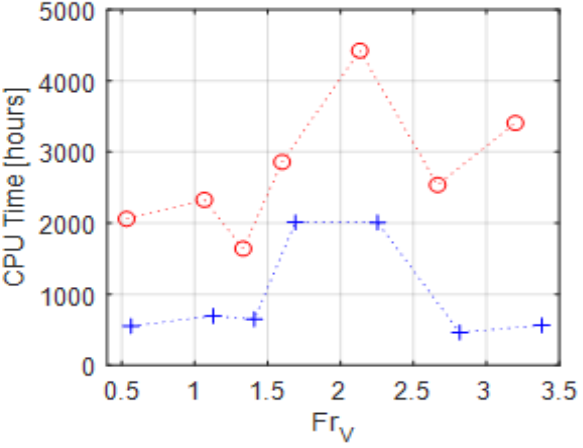
Figure 10. Central processing unit (CPU) times spent to achieve steady-state results for constant- deadrise hulls with LCG = 45% in light (blue crosses) and overloaded (red circles) conditions.